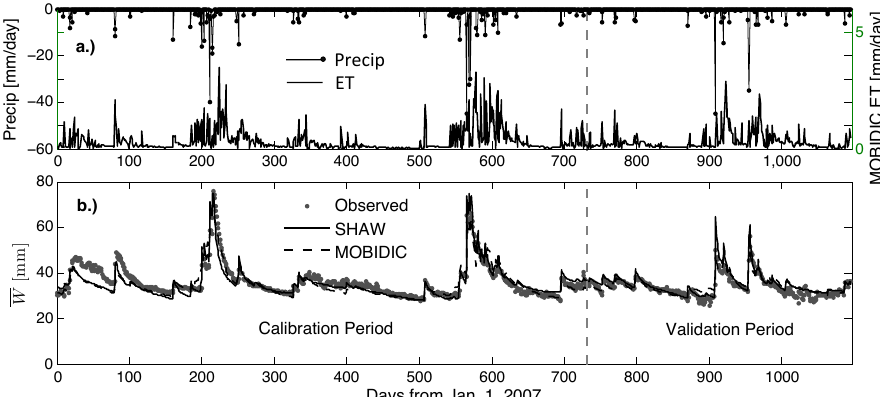
Figure 3. (a) Observed precipitation [mmday − 1 ] and MOBIDIC-simulated ET [mmday − 1 ]; (b) observed equivalent depth [cm] of soil water stored in the top 50cm vs. corresponding values simulated by SHAW and MOBIDIC for Site